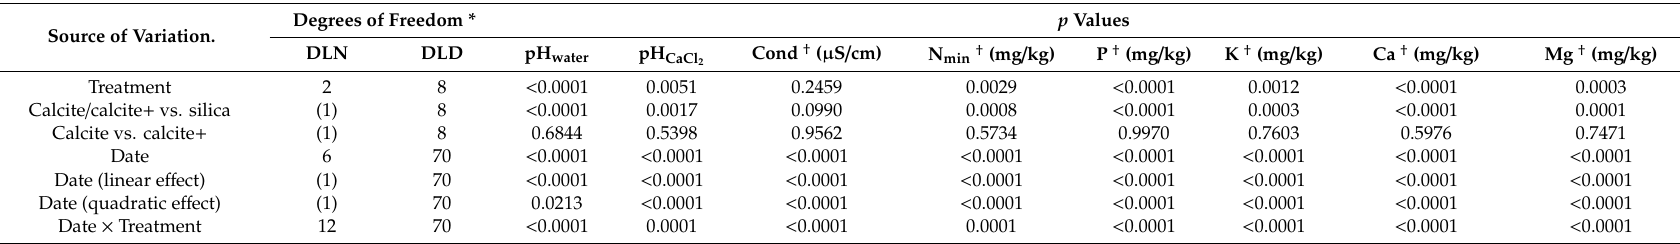
Table 1. Observed probabilities ( p -values) and degrees of freedom of the fixed e ff ects associated with the analysis of the variance of the fertility and physicochemical variables of the substrate during the second (2 + 0) growing season of white spruce seedlings in a forest nursery. A p -value in bold indicates a significant Date × Treatment interaction at p < 0.05.